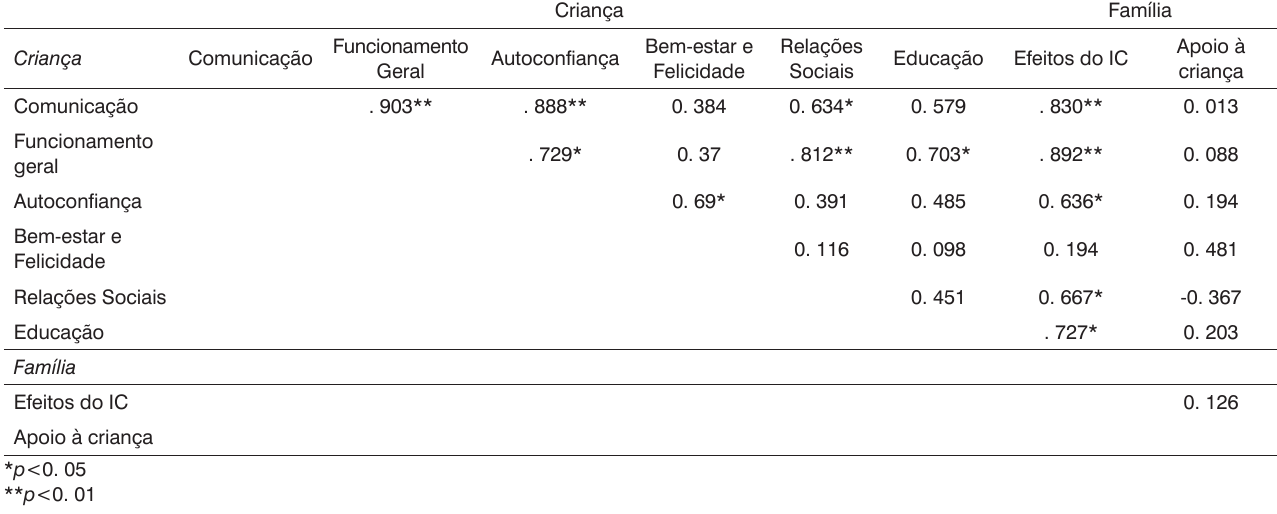
Figura 1: Médias das percepções dos pais nas sub-escalas do questionário "Crianças com Implante Coclear: Perspectivas dos Pais" represen- tadas por box plots. Quanto maior a média, mais positiva a perspectiva dos Tabela 2. Coeficientes de correlação Spearman rho entre as subescalas do questionário "Crianças com Implante Coclear: Pers- pectivas dos Pais".